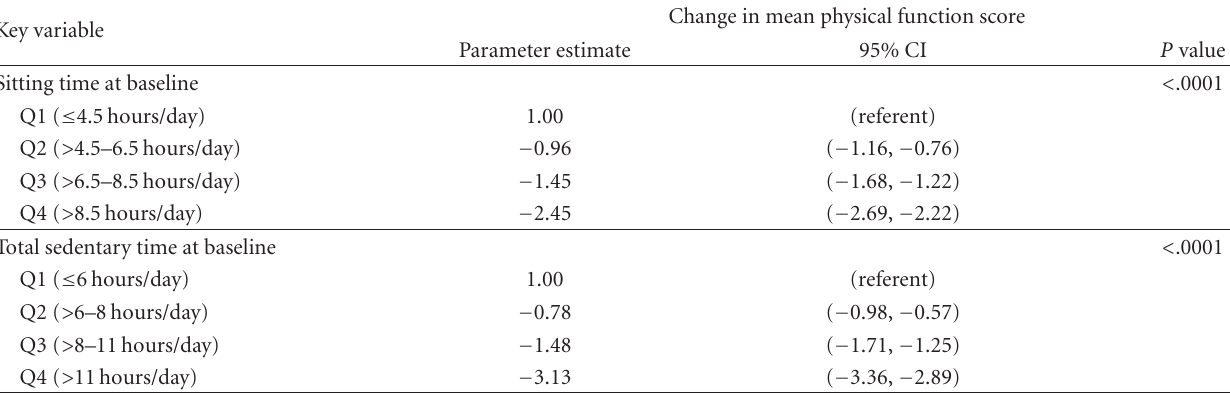
Table 3: Multivariate analysis of change in physical function score over time between WHI-OS baseline and WHI-OSES follow up and daily sitting time and total sedentary time 5